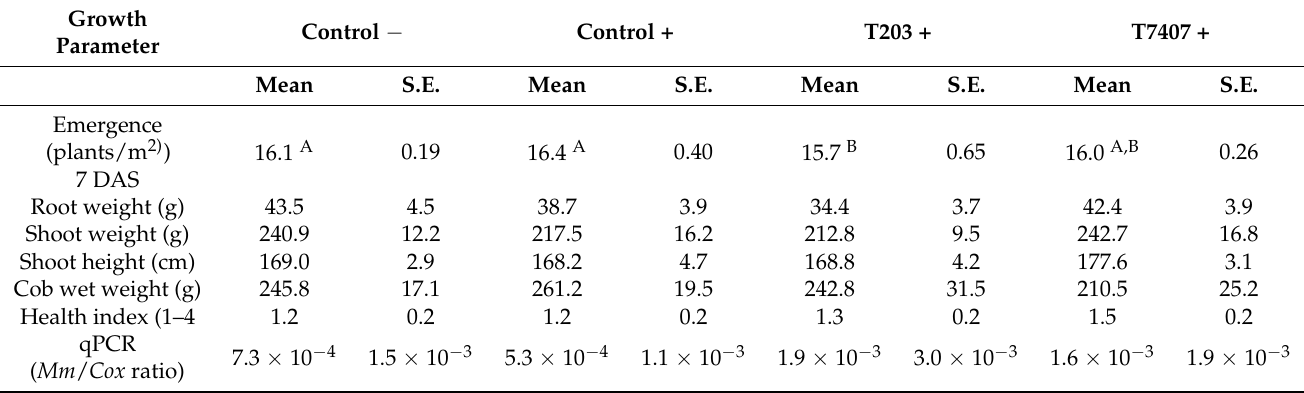
Table 4. Trichoderma spp. late wilt control in the 2019 growing season 1